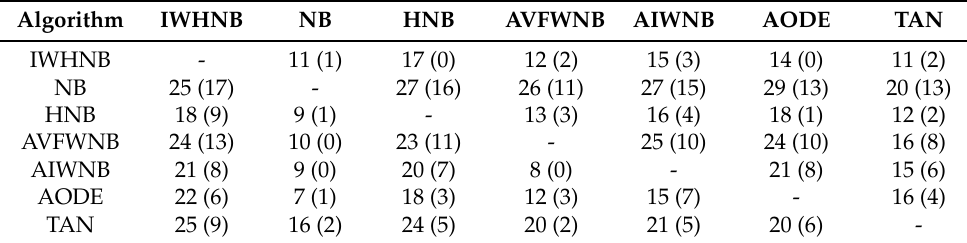
Table 2. Summary test results on classification accuracy.